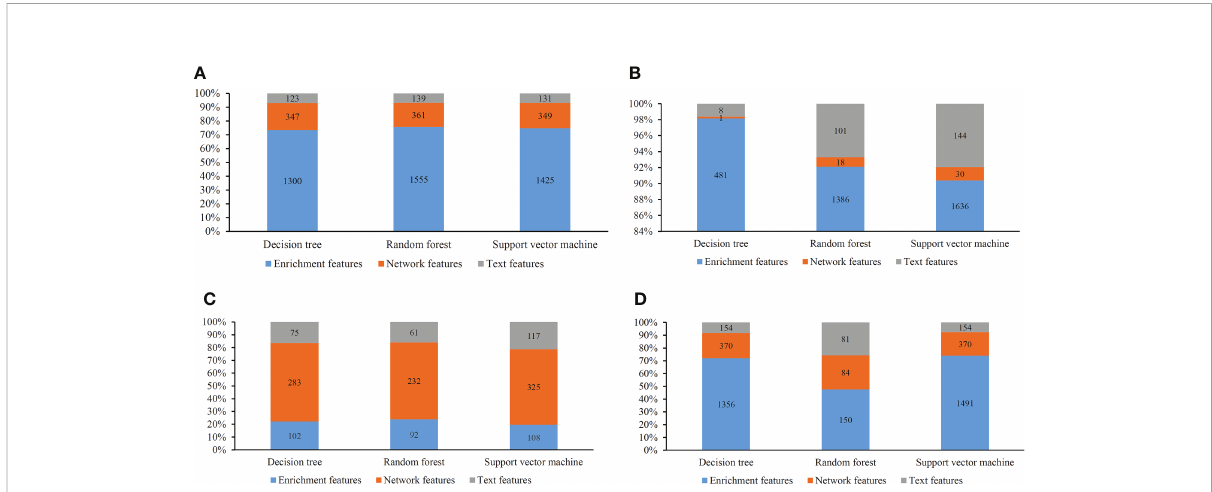
FIGURE 8 Distribution of the optimal features for different classi fi cation algorithms and feature lists. (A) Lasso feature list; (B) mRMR feature list; (C) MCFS feature list; (D) LightGBM feature